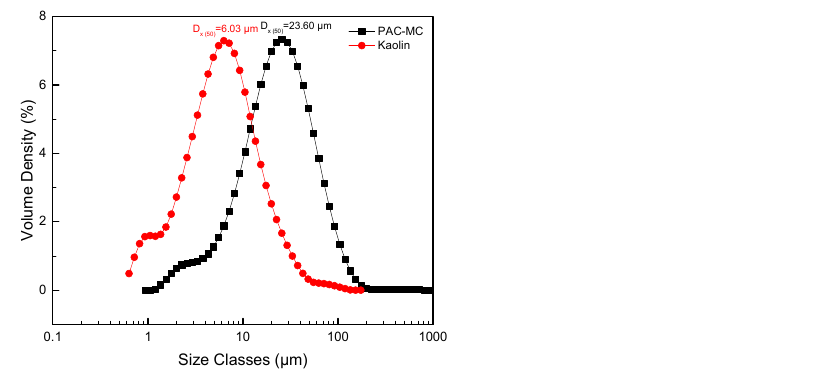
Figure 7. Particle size distribution of clay before and after PAC modification.